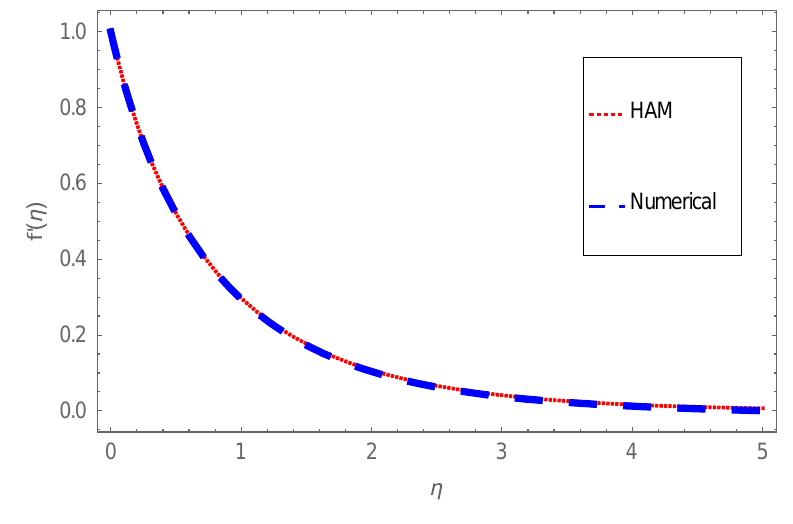
Figure 2. Dual solution for velocity field.